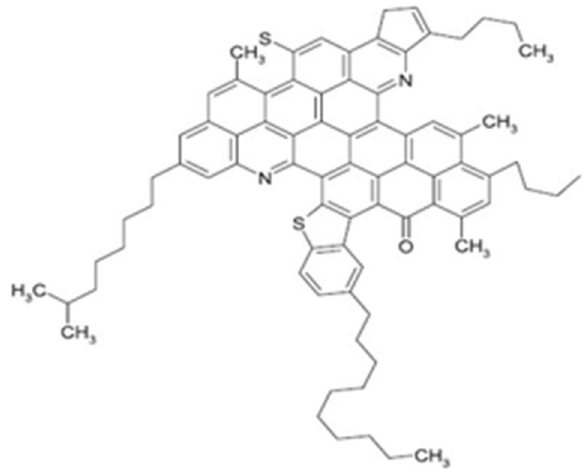
Fig. 6 Emulsions stabilized by asphaltenes (Kokal and Aramco 2005)